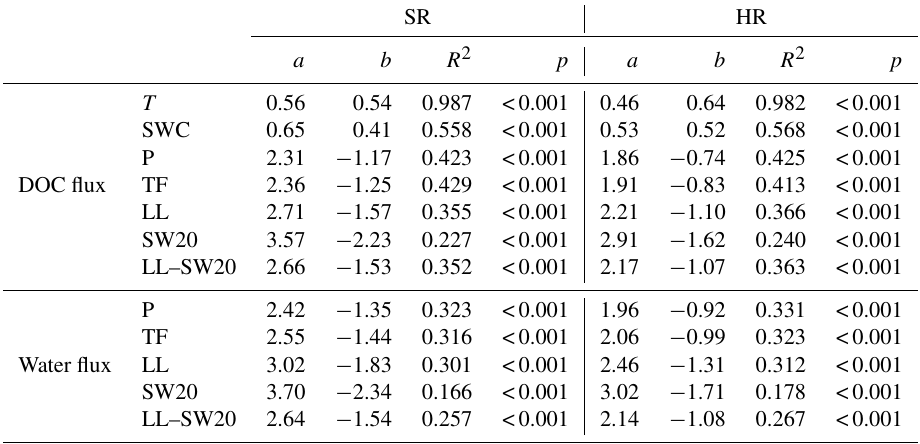
Table 3. Results of a regression analysis of the weekly water flux, DOC flux, soil respiration (SR), and heterotrophic respiration (HR) along the hydrological processes (TF, throughfall; LL, litter leachate) in the tropical rainforest in Xishuangbanna, south-west China.